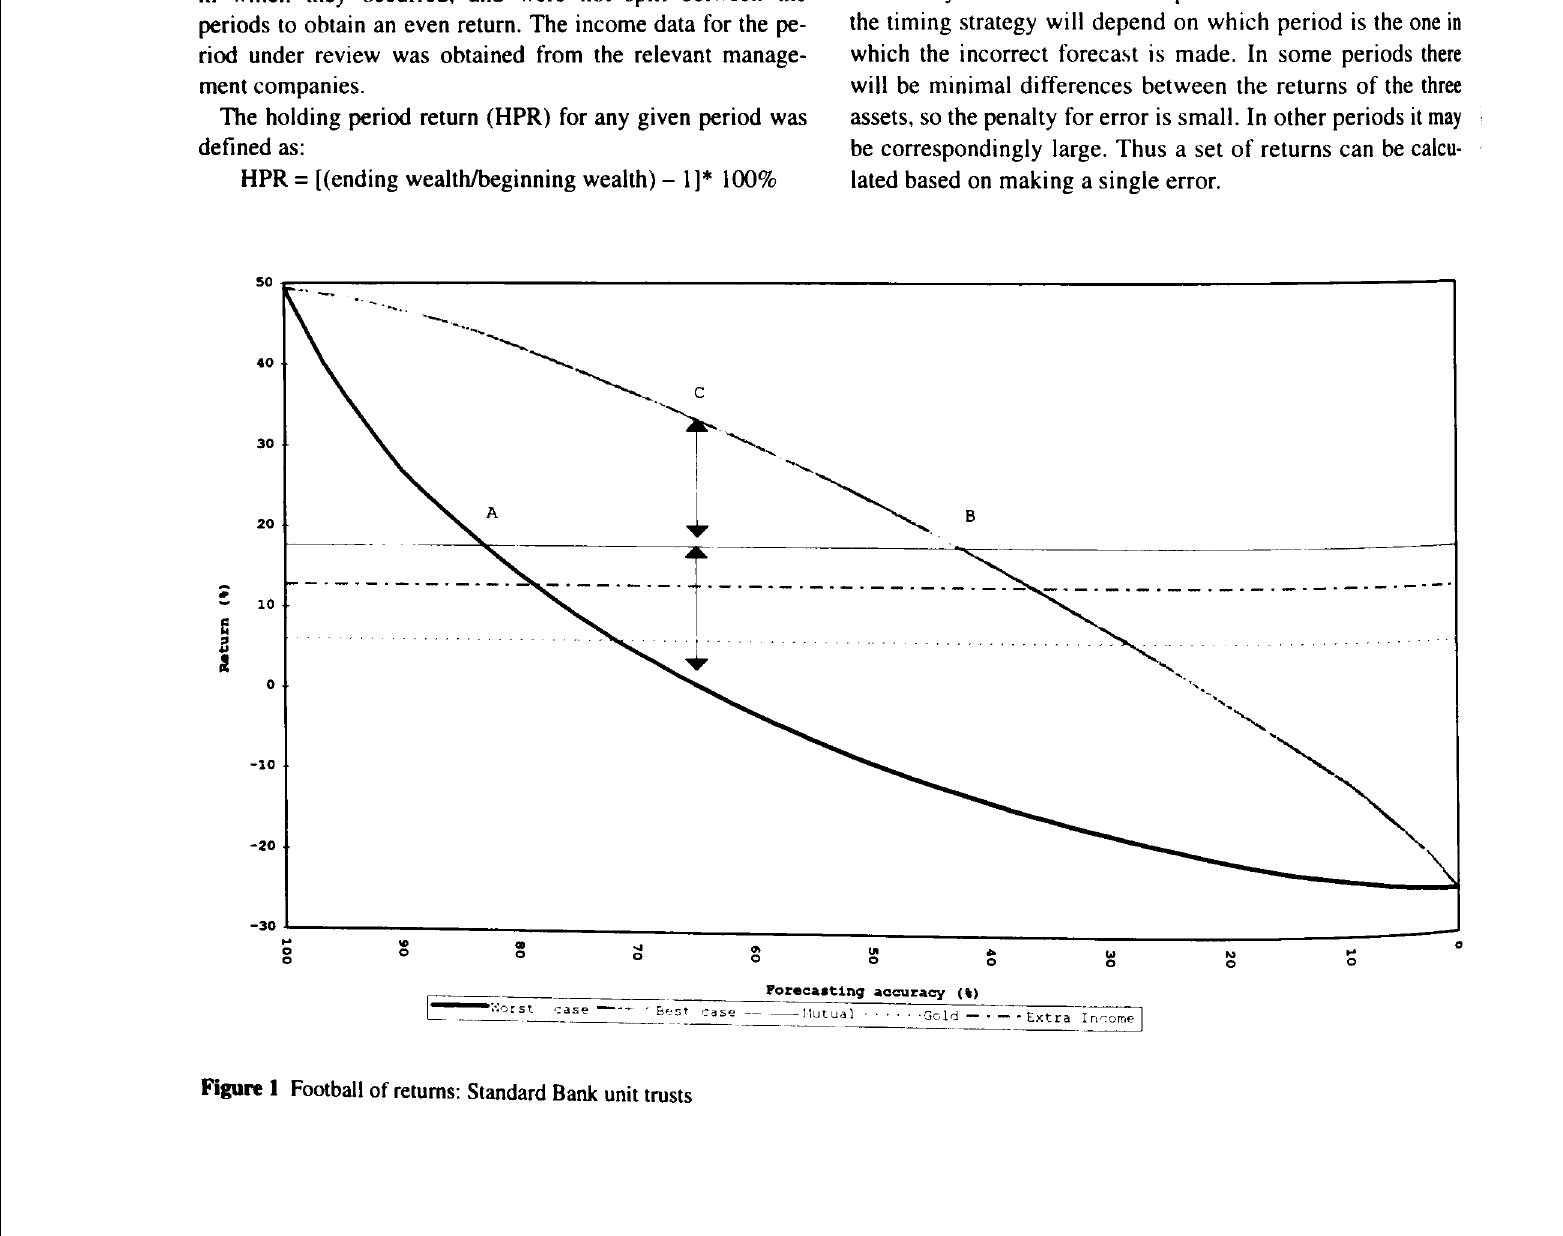
Figure I Football of returns: Standard Banlc unit